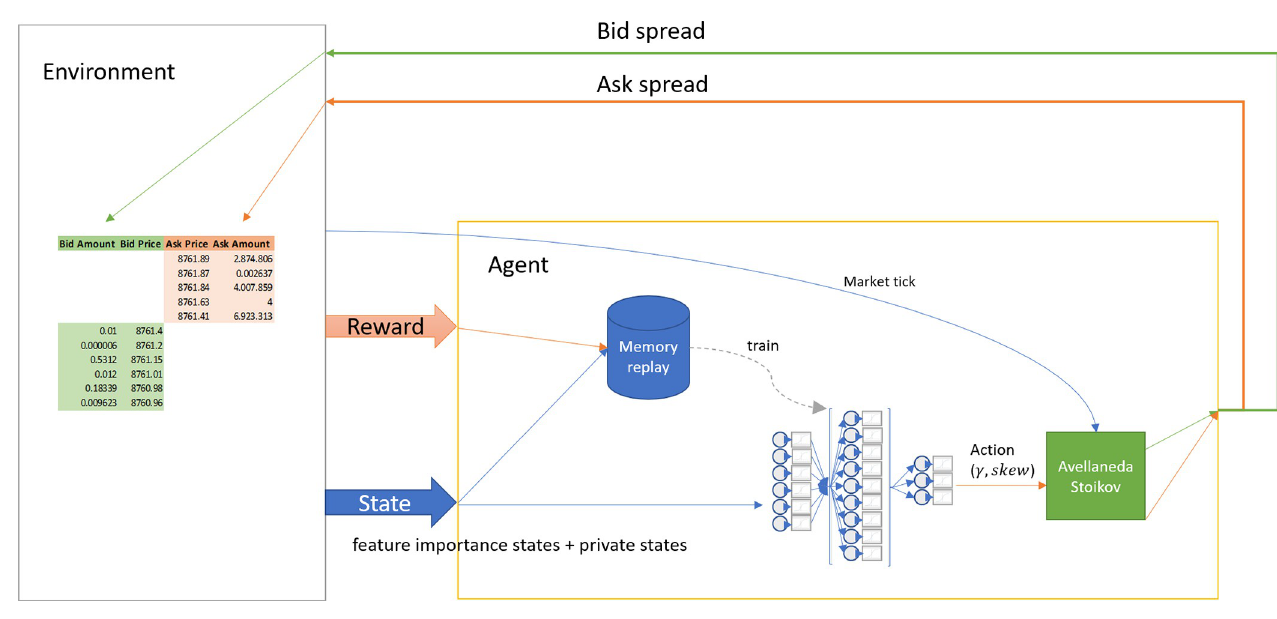
Fig 3. The Alpha-Avellaneda-Stoikov